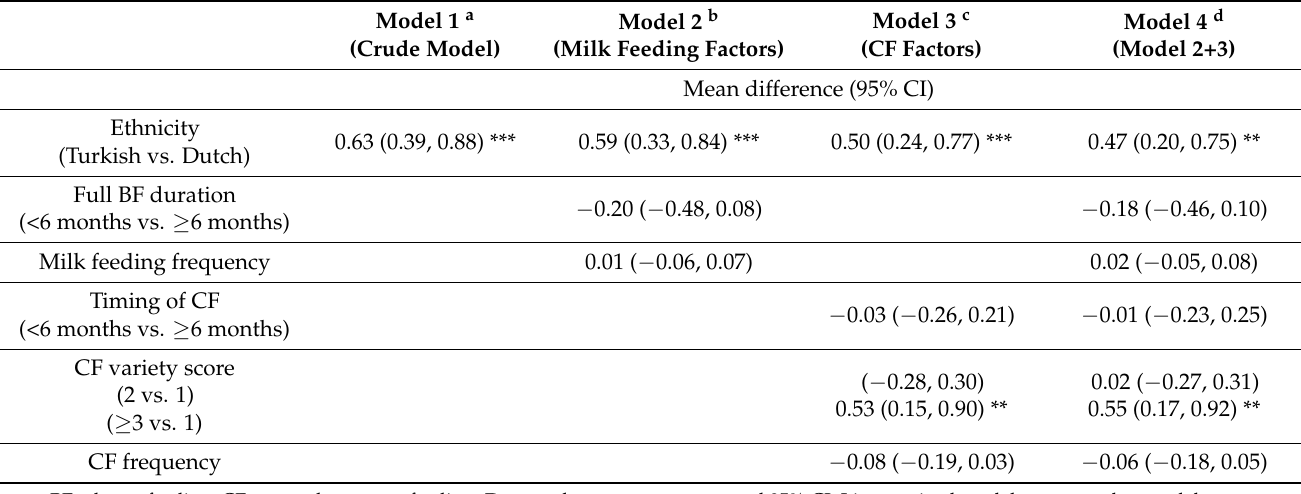
Table 4. Mean differences in estimated BMI-sds at age 5 years by ethnicity and feeding factors, derived from the LMR (models 1–4) and contribution of infant feeding